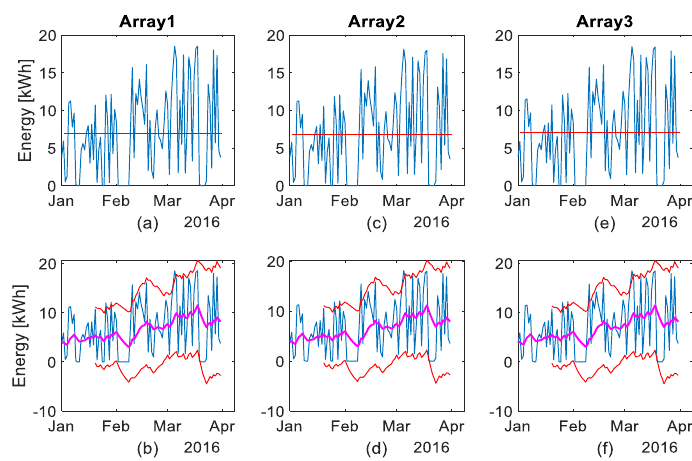
Figure 3. ( a ) Energy produced by array #1 in three months and its mean value as red line; ( b ) upper and lower BB 20 of array #1 in red color, and EMA 20 in magenta color. ( c ) and ( d ) refer to array #2. ( e ) and ( f ) refer to Array #3.